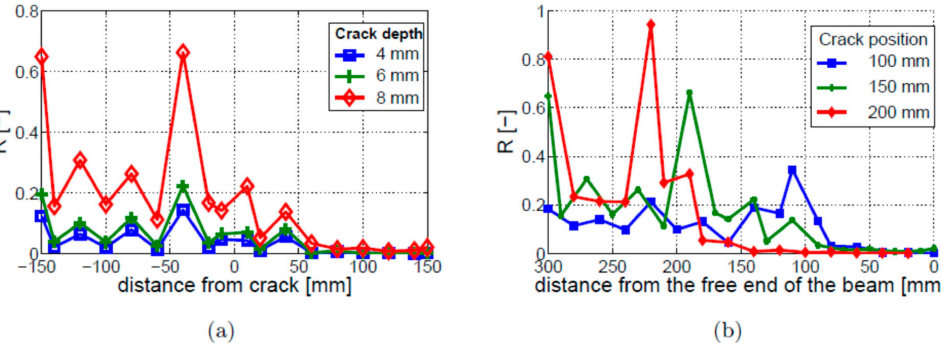
Figure 15. Parametric study of nonlinear vibro-acoustic modulations for the breathing crack model and the piezo model of ultrasonic HF excitation: ( a ) crack depth; ( b ) crack localization